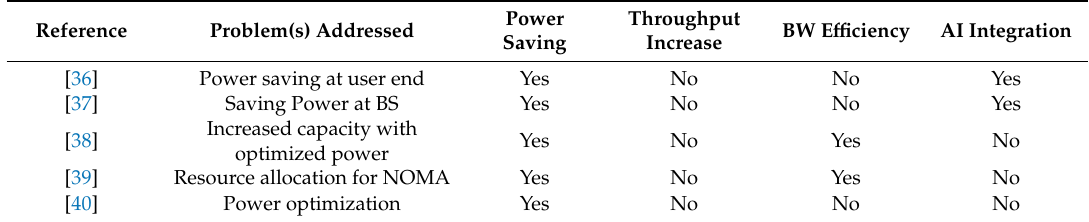
Table 1. A glimpse of the literature survey.